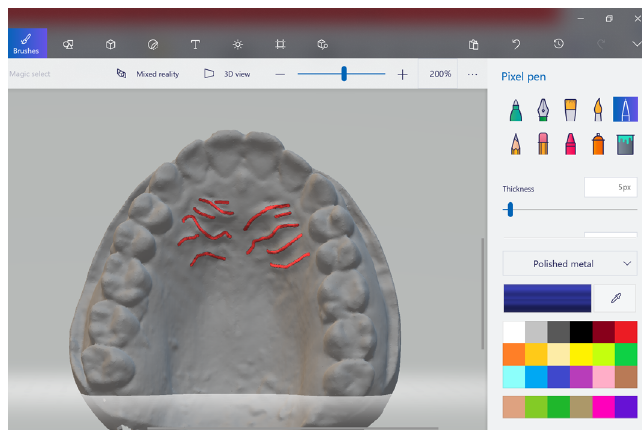
Figure 2. Rugae highlighting on Paint 3D software.